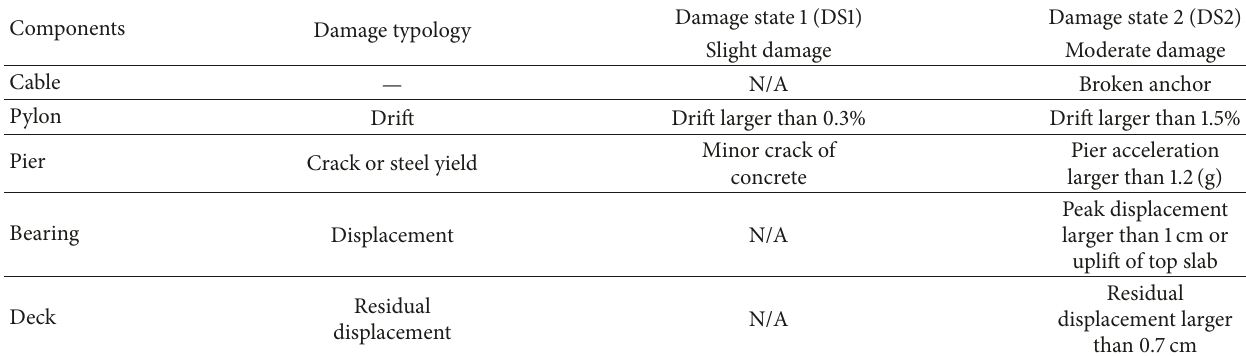
Table 3: Damage scheme for the correlation of the visual damage to the damage state.